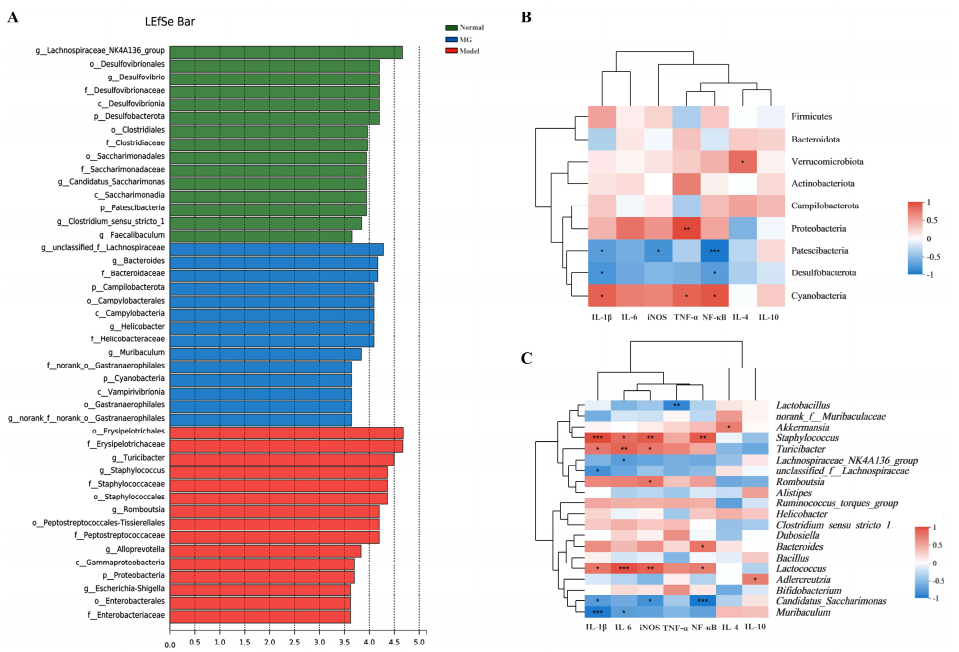
Figure 8. Correlation analysis between gut immunity inflammatory cytokines and gut microbiota. ( A ) Differentially enriched gut microbiota in three groups of mice by linear discriminant analysis (LDA) at the genus level. ( B ) Correlation matrix showing the strength of the correlation between gut immunity inflammatory cytokines and gut microbiota in the colon at the phylum level. ( C ) Correlation between gut immunity inflammatory cytokines and gut microbiota in the colon at the genus level. Spearman r values range from −1 (blue) to 1 (red). * p < 0.05, ** p < 0.01, and *** p < 0.001 vs. the normal